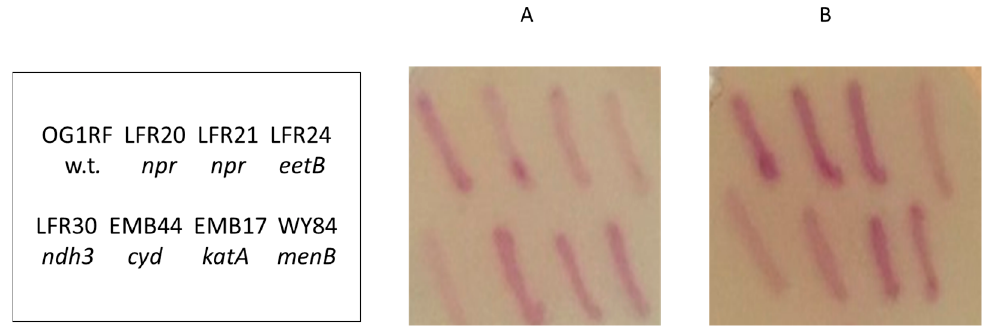
Figure 1. Colony ferric reductase activity of E. faecalis strains determined by Ferrozine zymogram staining. Panel ( A ), TSBG plate supplemented with 0.2 mM ammonium iron(III) sulfate. Panel ( B ), same medium as in Panel ( A ) and with 5 µM hemin added. The identity of the strains grown as streaks on the plates and their respective gene defect are indicated in the left-hand panel.